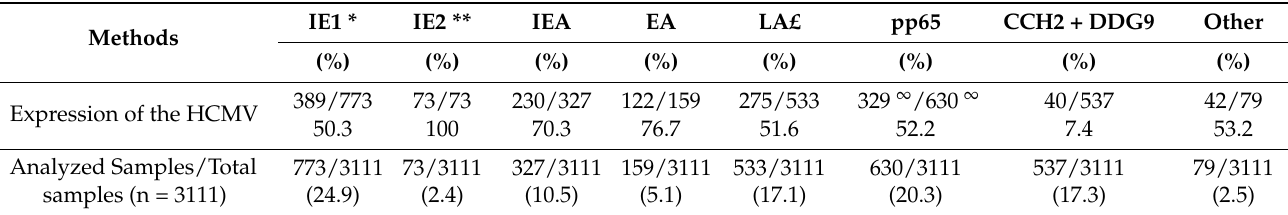
Expression of the